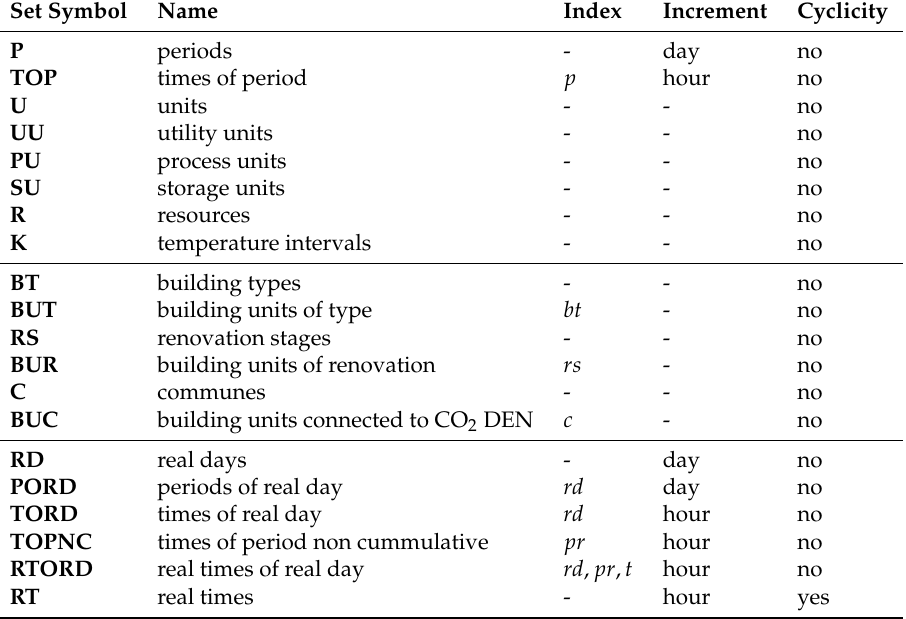
Table 1. Sets used in the mathematical